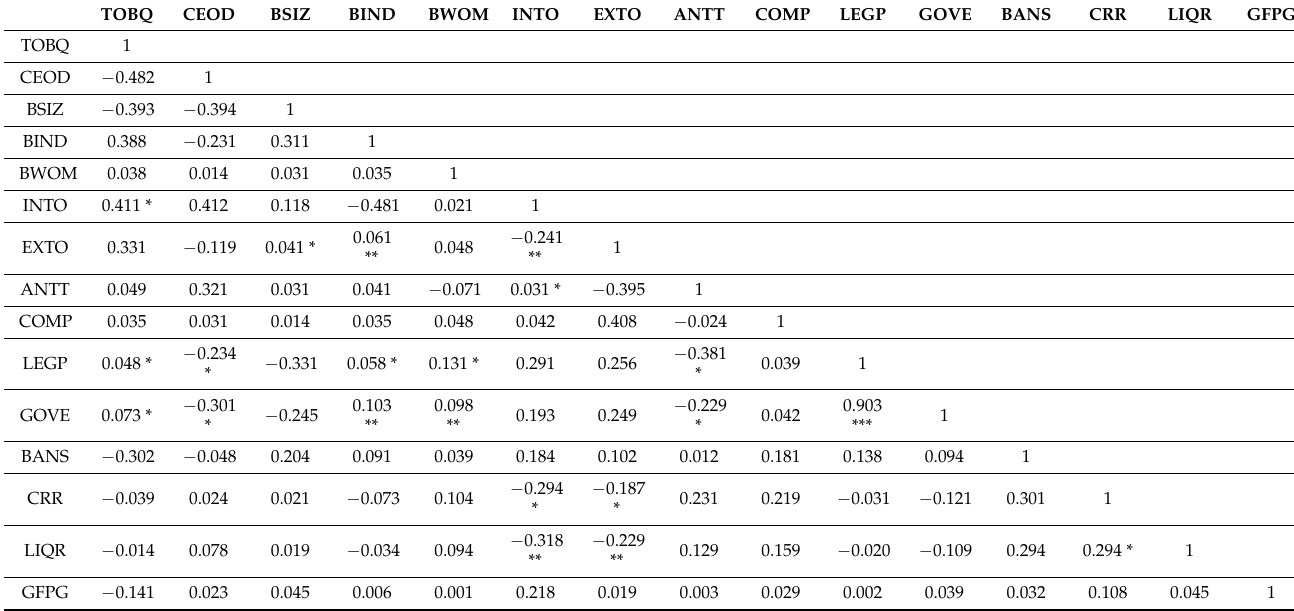
Table 6. Correlations of